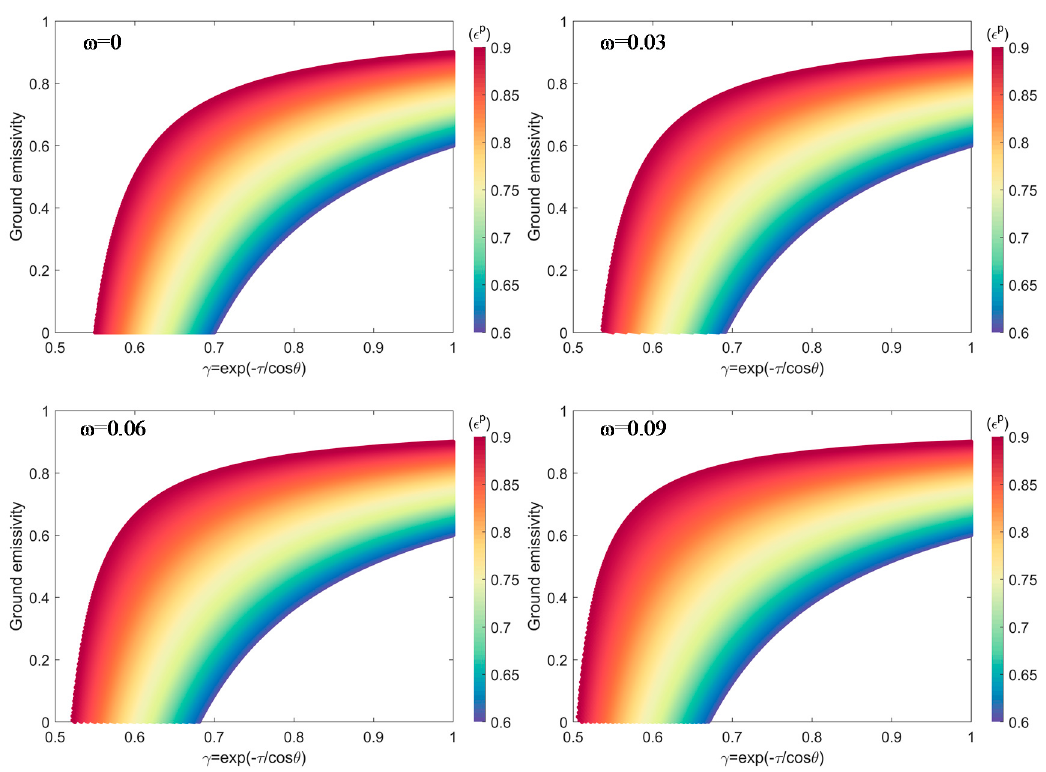
Figure 11. Relationship between the vegetation transmissivity and ground emissivity.